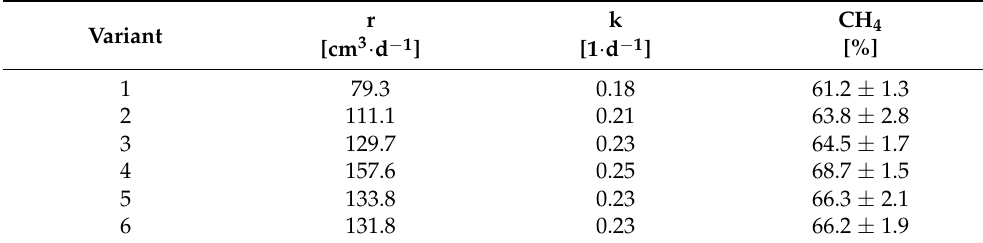
Figure 3. Course of biogas production in experimental variants. Table 2. Biogas production rate (r), reaction rate constants (k), and methane content of biogas (CH 4 ).